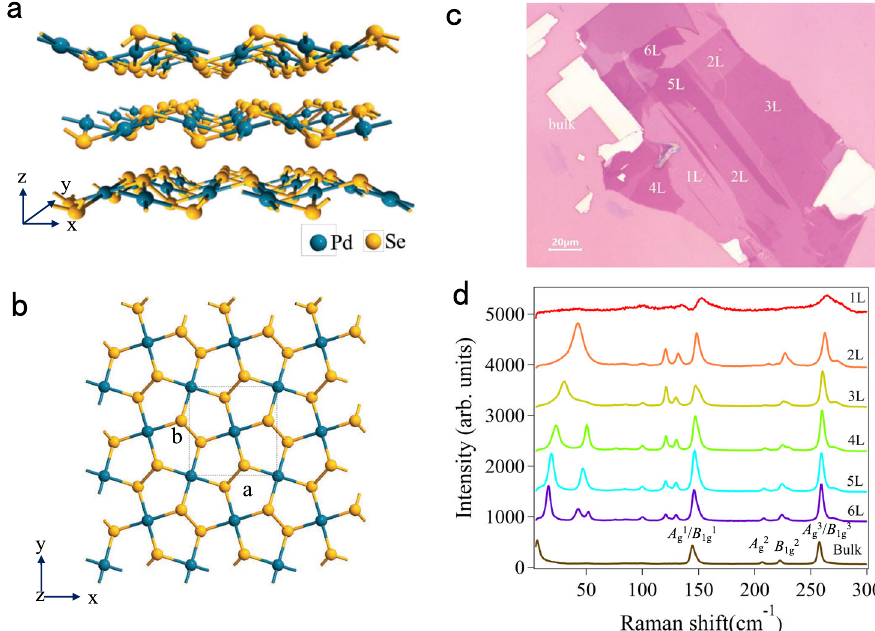
Fig. 1 Crystallographic structure and optical characteristics of a few-layer PdSe 2 . a The lattice structure of PdSe 2 fl akes with a puckered pentagonal. The unit cell vectors are denoted by the x, y, and z. Blue and yellow globes denote the Pd and Se atoms, respectively. b Top view of the atomic crystal structure of monolayer PdSe 2 . The black dotted frame represents a unit cell of PdSe 2 . The a and b denote the lattice constants along the x and y directions, respectively. c The optical microscope image of a few-layer PdSe 2 on the silicon substrate with a 285 nm SiO 2 layer. The numbers of sample layers containing 1 – 6 L were marked with white letters, and the scale bar is 20 μ m. d Raman spectra of the 1 – 6 L and bulk PdSe 2 fl akes with the same intensity axis. The low-frequency Raman peaks (0 − 100 cm − 1 ) were robust and even exceeded that of the high-frequency modes. The Raman vibration modes of bulk PdSe 2 were marked as A g 1 , A g 2 , A g 3 , B 1g 1 , B 1g 2 , and B 1g 3